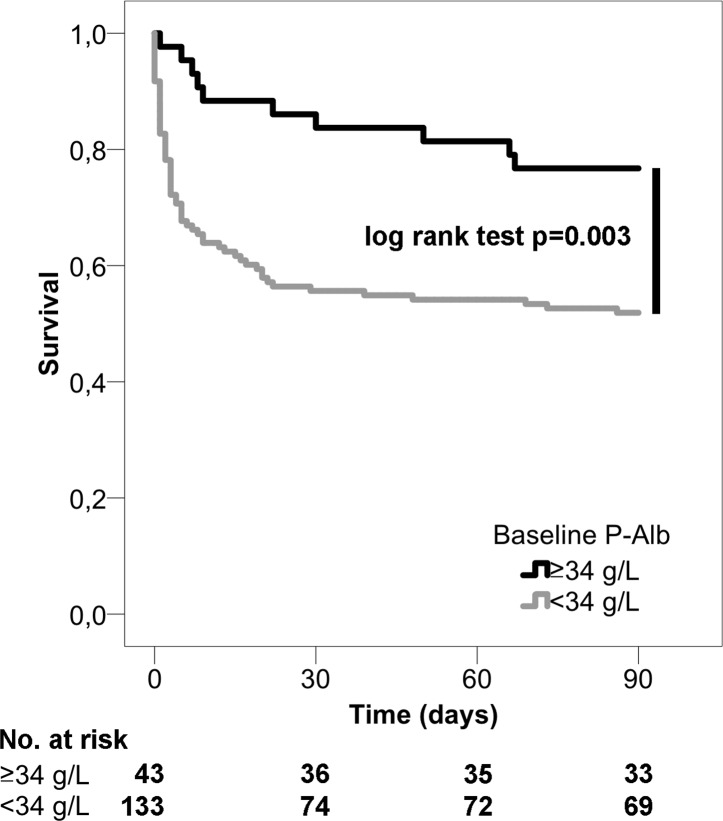
Kaplan-Meier survival curves of 90-day mortality according to baseline plasma albumin (P-Alb).